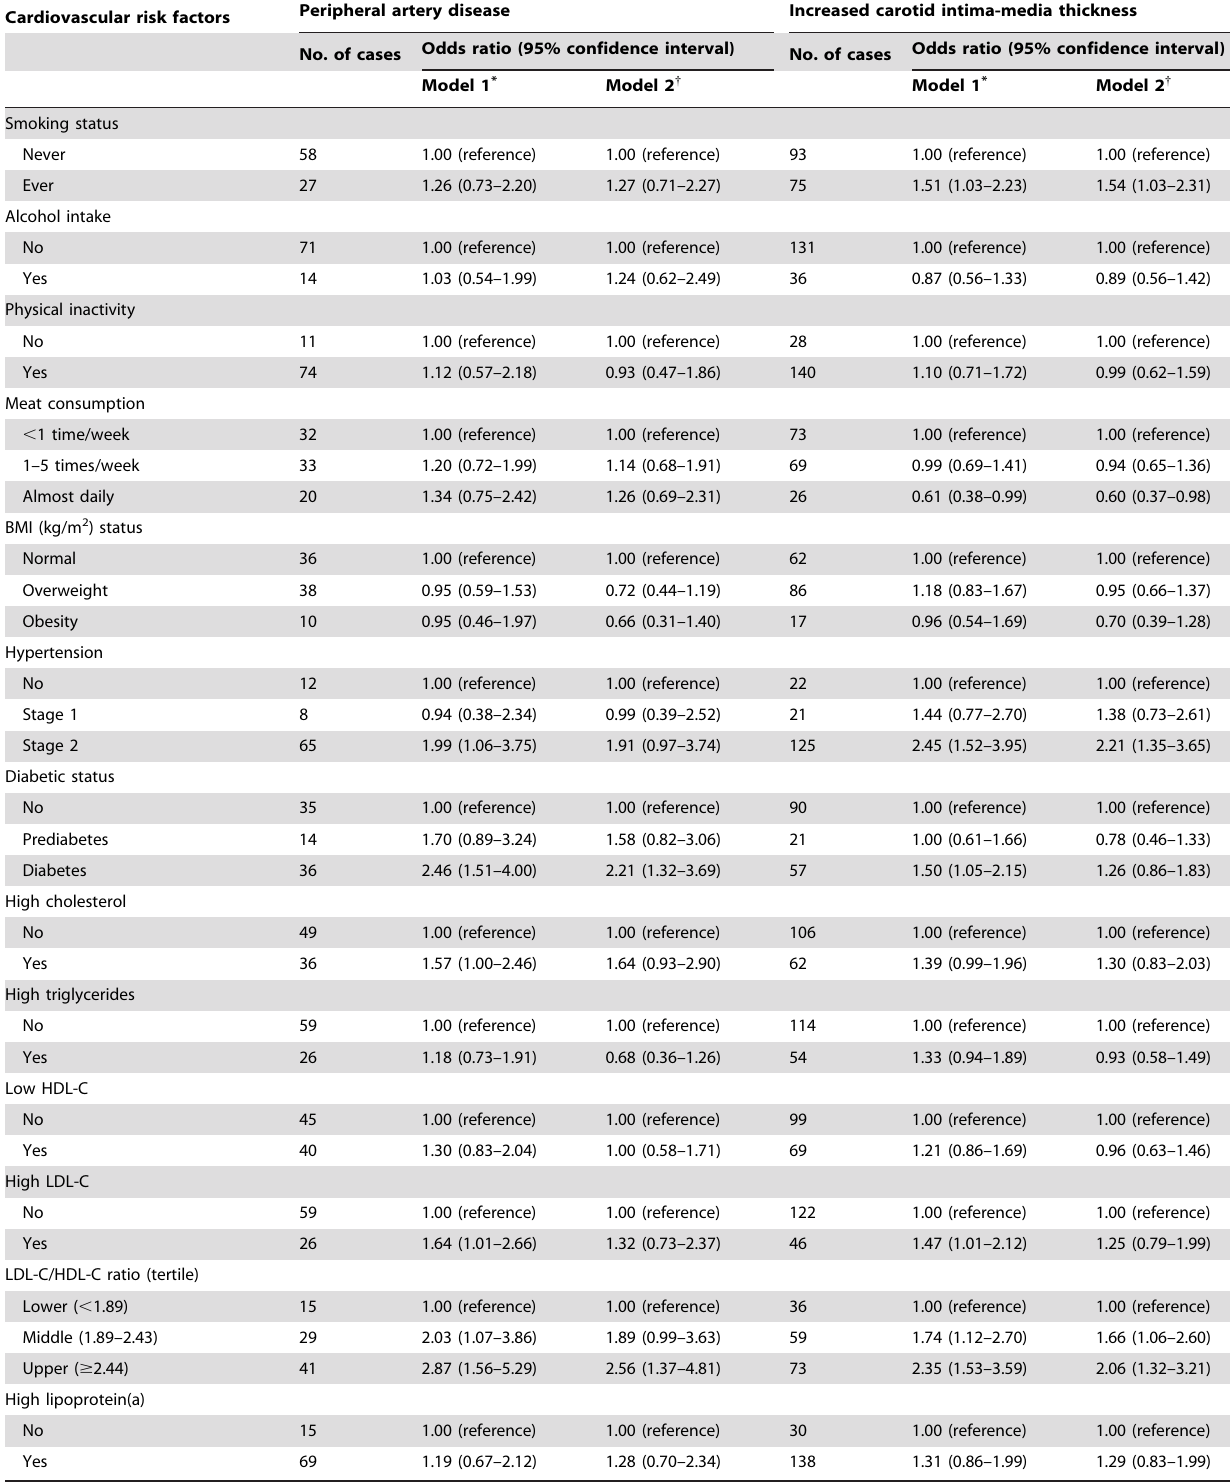
Table 2. Association of cardiovascular risk factors with peripheral artery disease and increased carotid intima-media